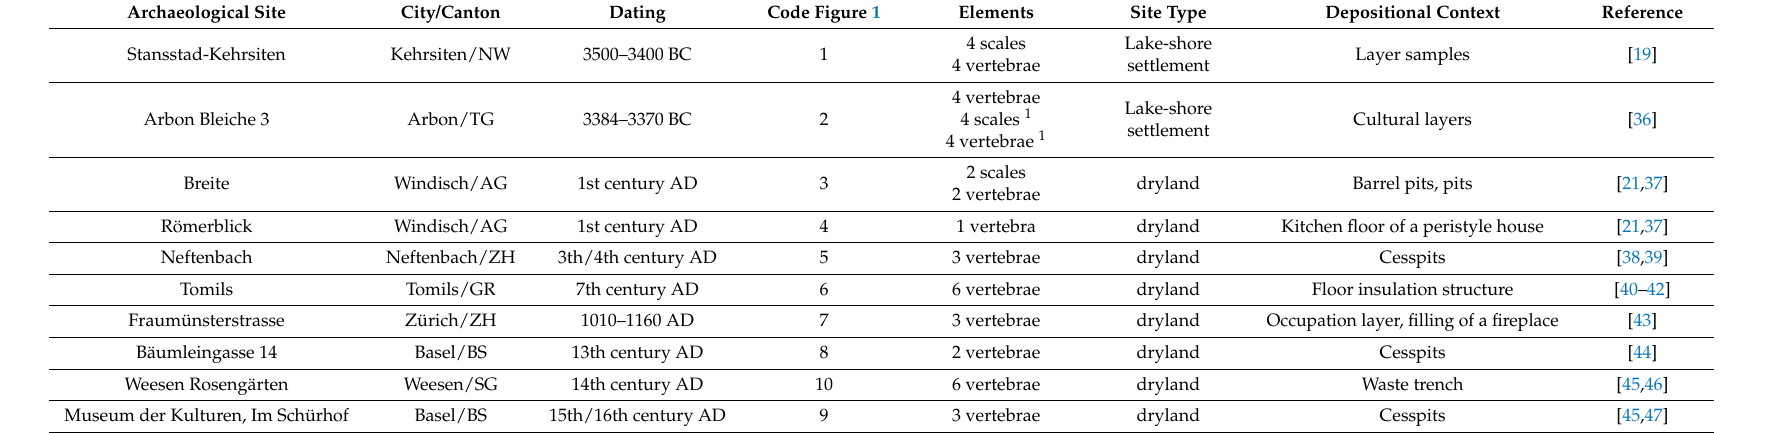
Table 1. Specifications of archaeological sites from which whitefish remains were taken for this